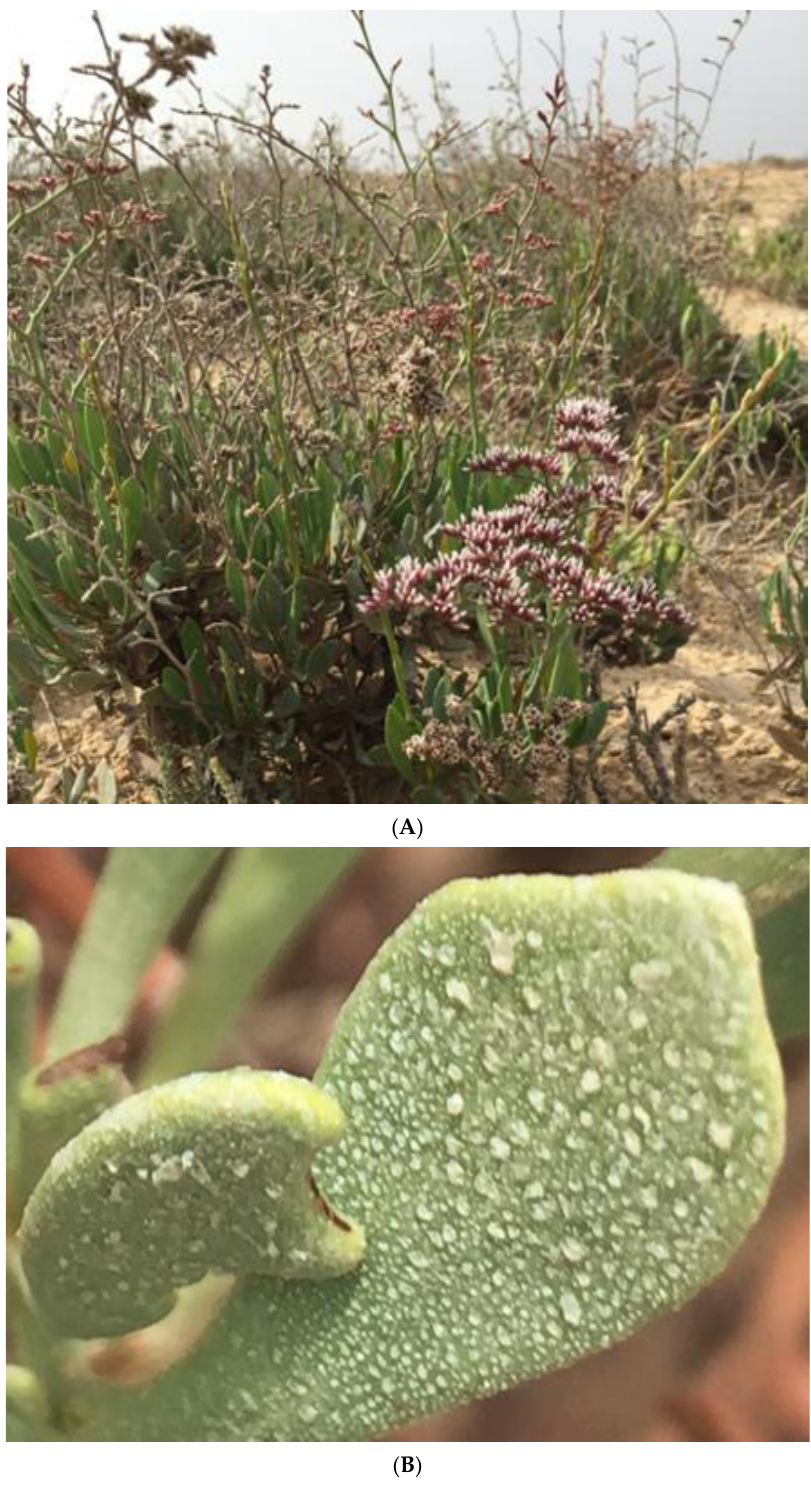
Figure 2. Limonium axillare thrives in salt marshes ( A ). Observe the salt crystals on the leaf surface in salt marshes ( B ). Salt glands secrete salts on the leaf surfaces through small holes.